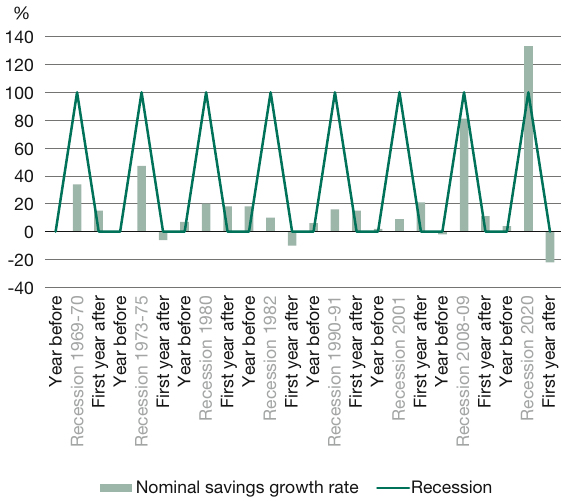
Nominal personal savings, annual growth rate, all recession episodes, US,